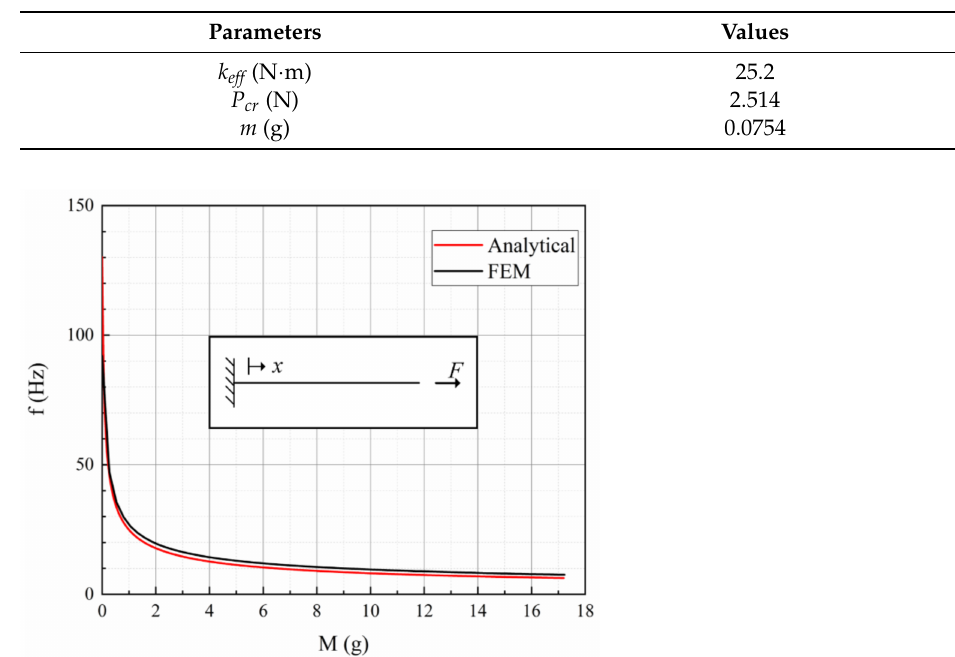
Table 1. Critical parameters used the resonant frequency calculation.